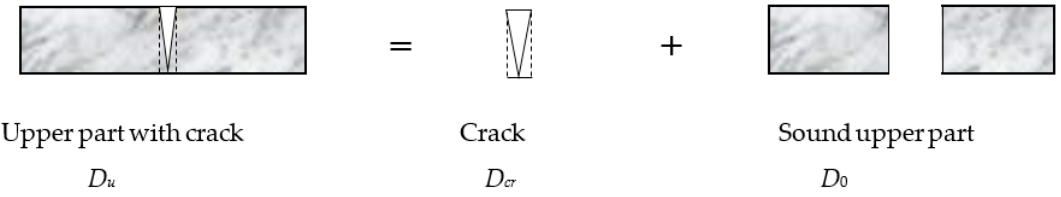
Figure 2. Partition hypothesis of resistance for the upper part with crack.